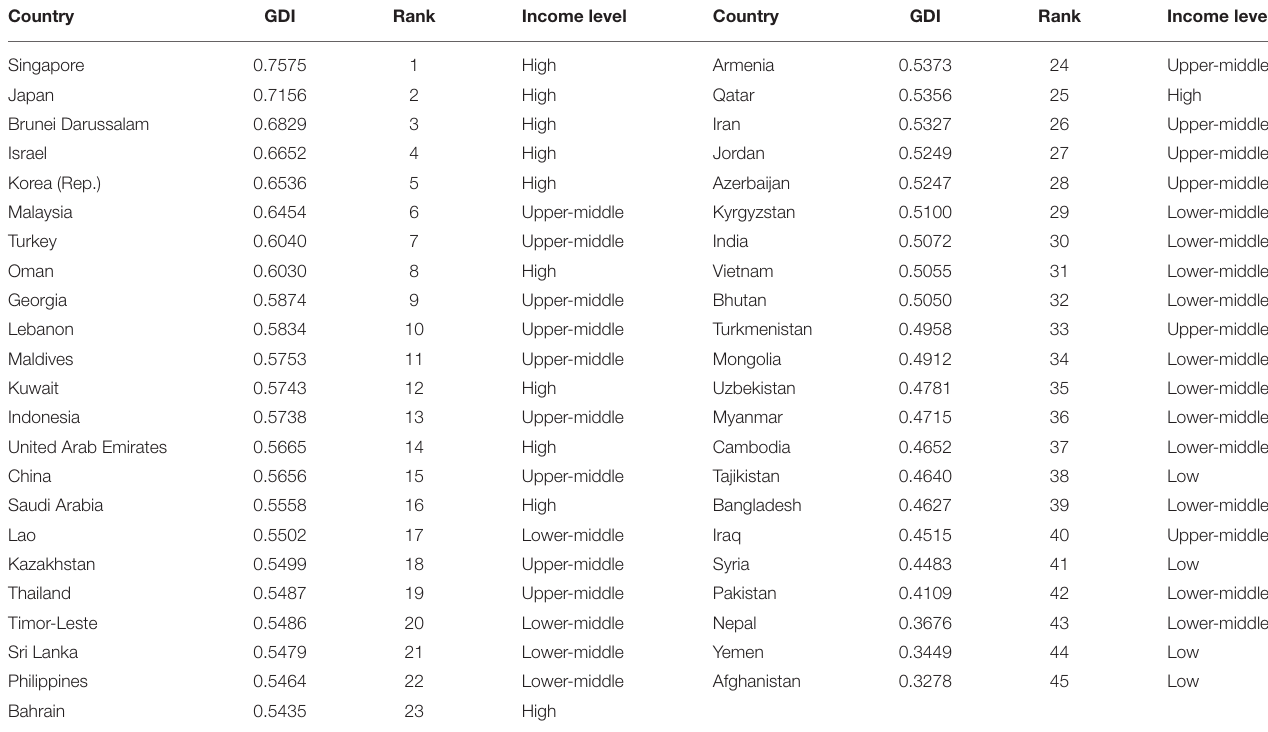
TABLE 3 | The mean value of GDI and its ranking from 2010 to 2016.